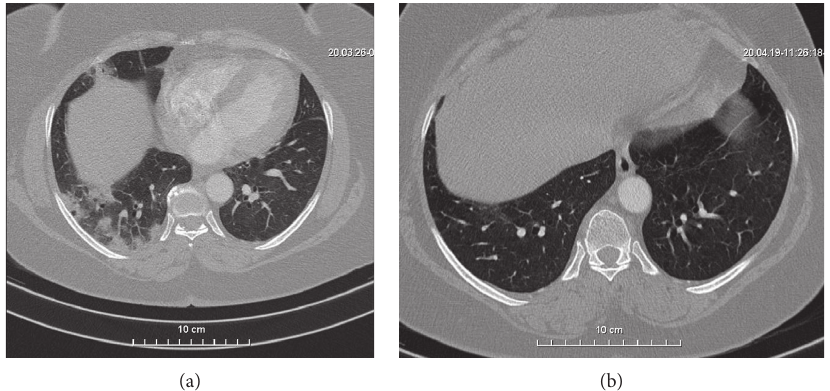
Figure 2: (a) Chest computed tomography (CT) scans (transverse plane) of the patient 2: multifocal nodular condensations with halo sign (peripheral frosted glass) under right posterobasal and anterobasal pleura. (b) Chest computed tomography (CT) scans (transverse plane) control of the patient 2: favorable evolution with disappearance of nodular condensations under right posterobasal pleura.